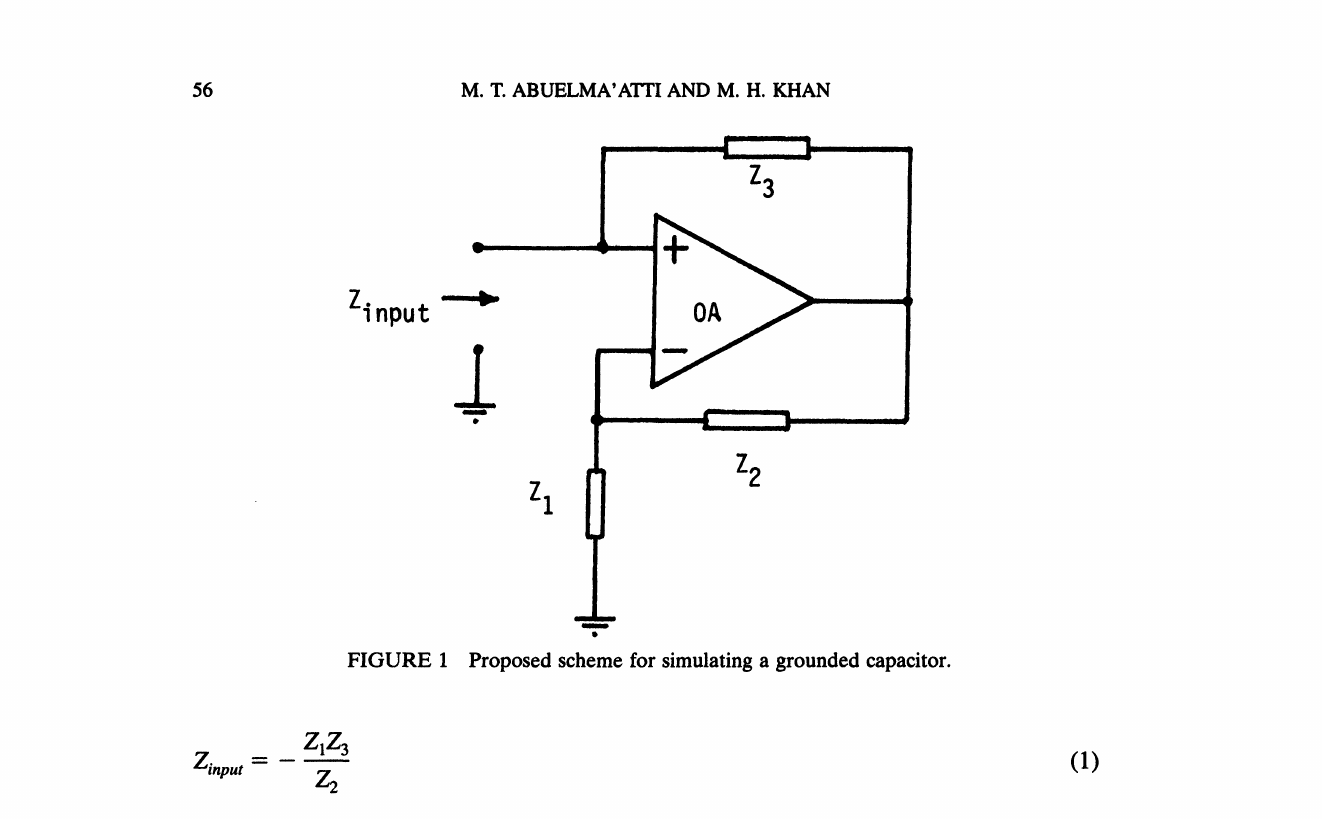
FIGURE 1 Proposed scheme for simulating a grounded